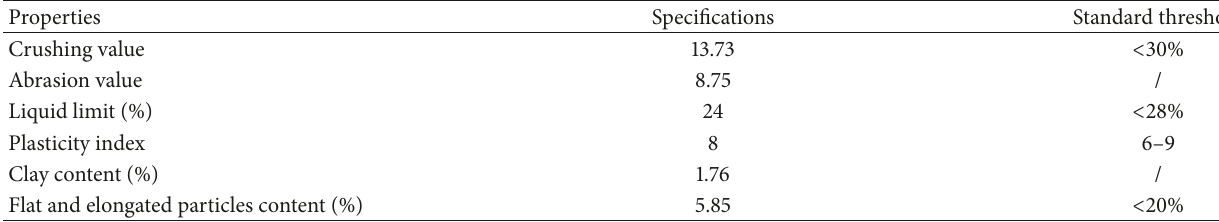
Figure 1: Grading curves of the cement stabilized macadam. Table 2: Technical specifications of the aggregates.